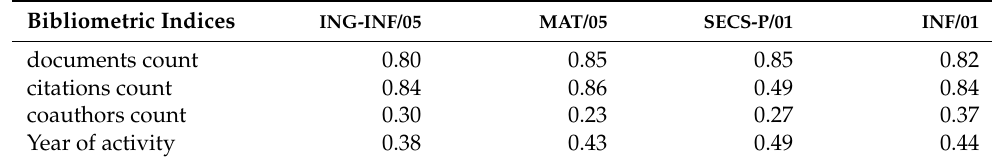
Figure 5. Correlation among H-index and bibliometric indices in the academic disciplines, from left to right academic disciplines are: MAT/05 , SECS-P/01 , ING-INF/05 , and INF/01 . Table 5. Pearson’s correlation among H-index and bibliometric indices in the academic disciplines. Bibliometric Indices